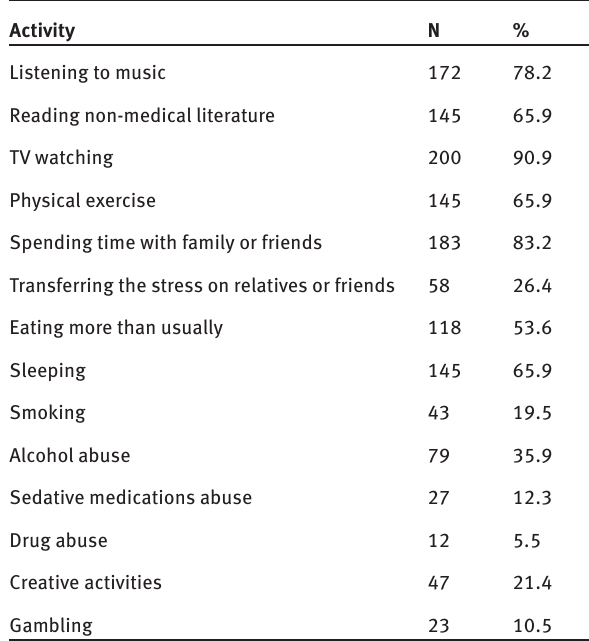
Table 5: Favorite after-work activities of respondents (prevalence at least once a